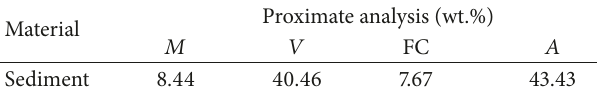
Table 2: Proximate analysis of the raw